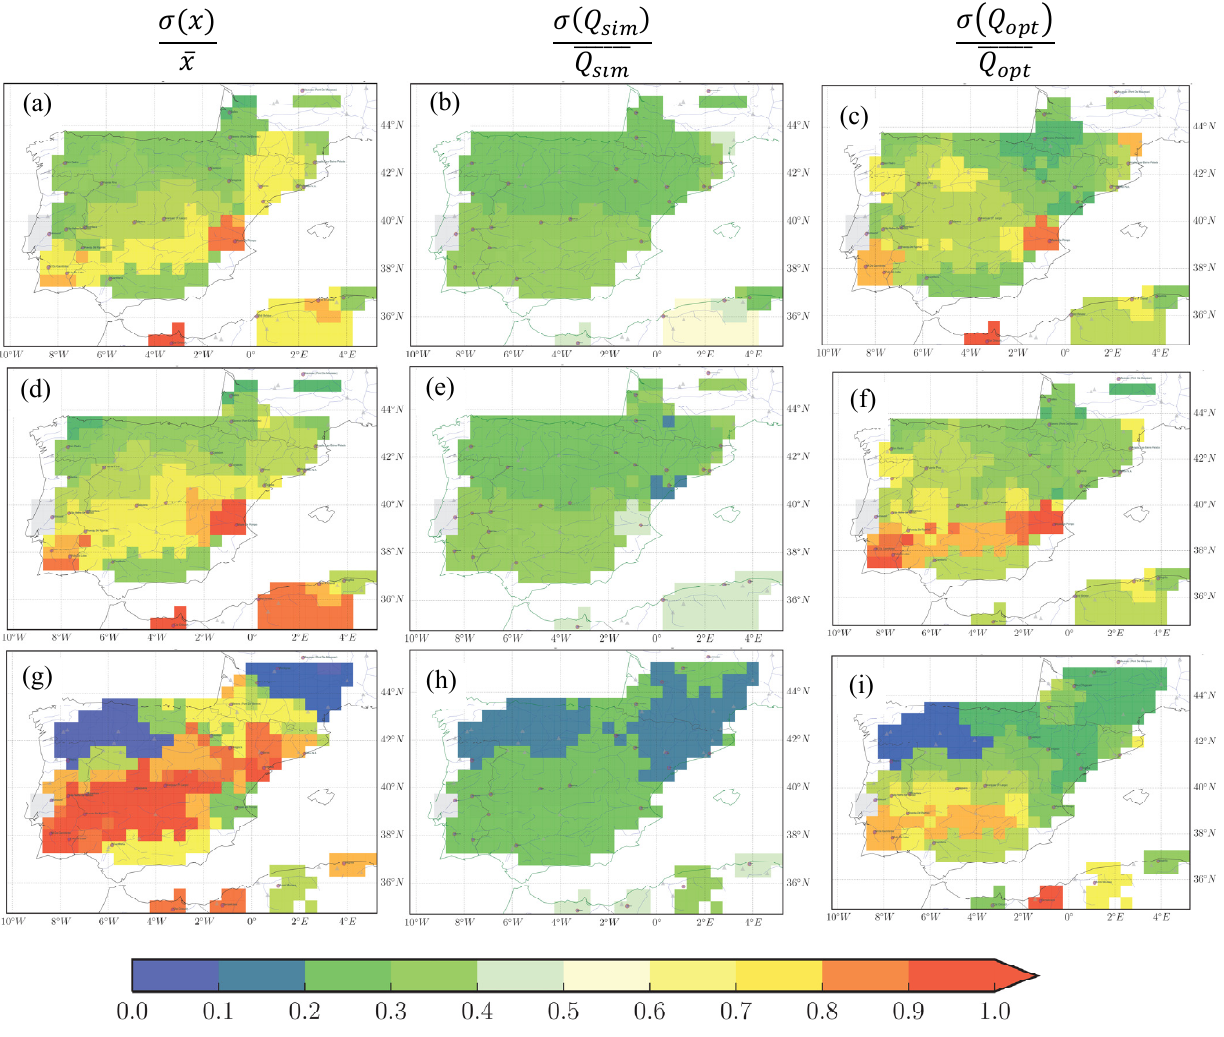
Figure 11. The interannual variation in correction factor x ( σ(x) ; a, d, g ), simulated river discharge without assimilation ( σ(Q sim ) x σ (cid:0) Q opt (cid:1) and optimized river discharge ( ; c, f, i ) for Y1SP0_WFDEIGPCC (1st row), Y1SP0_WFDEICRU (2nd row) and Y1SP0_CRUNCEP Q opt (3rd row) averaged over